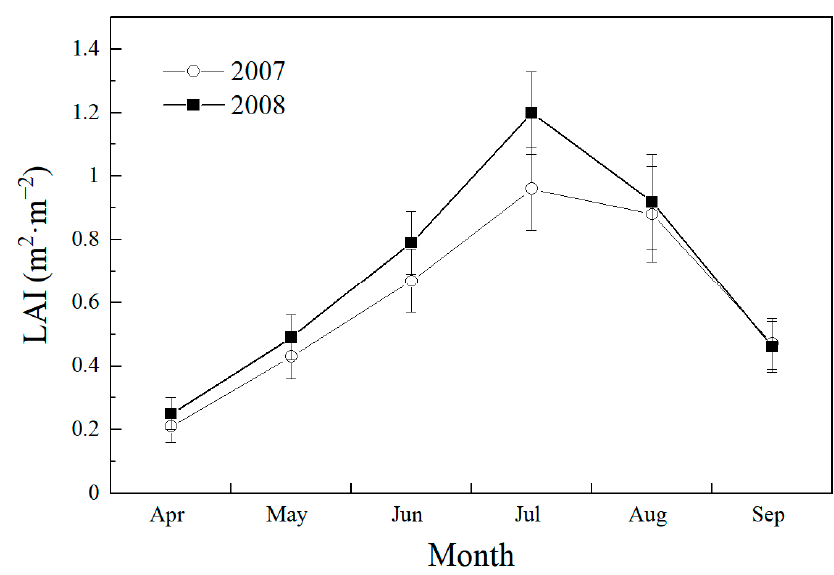
Figure 1. Variation of leaf area index ( LAI ) during the growing season in 2007 and 2008.